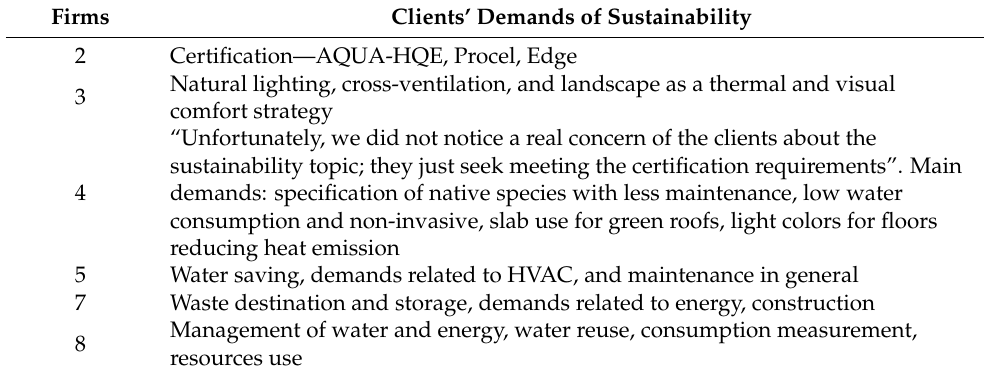
Table 2. Demands of sustainability aspects.